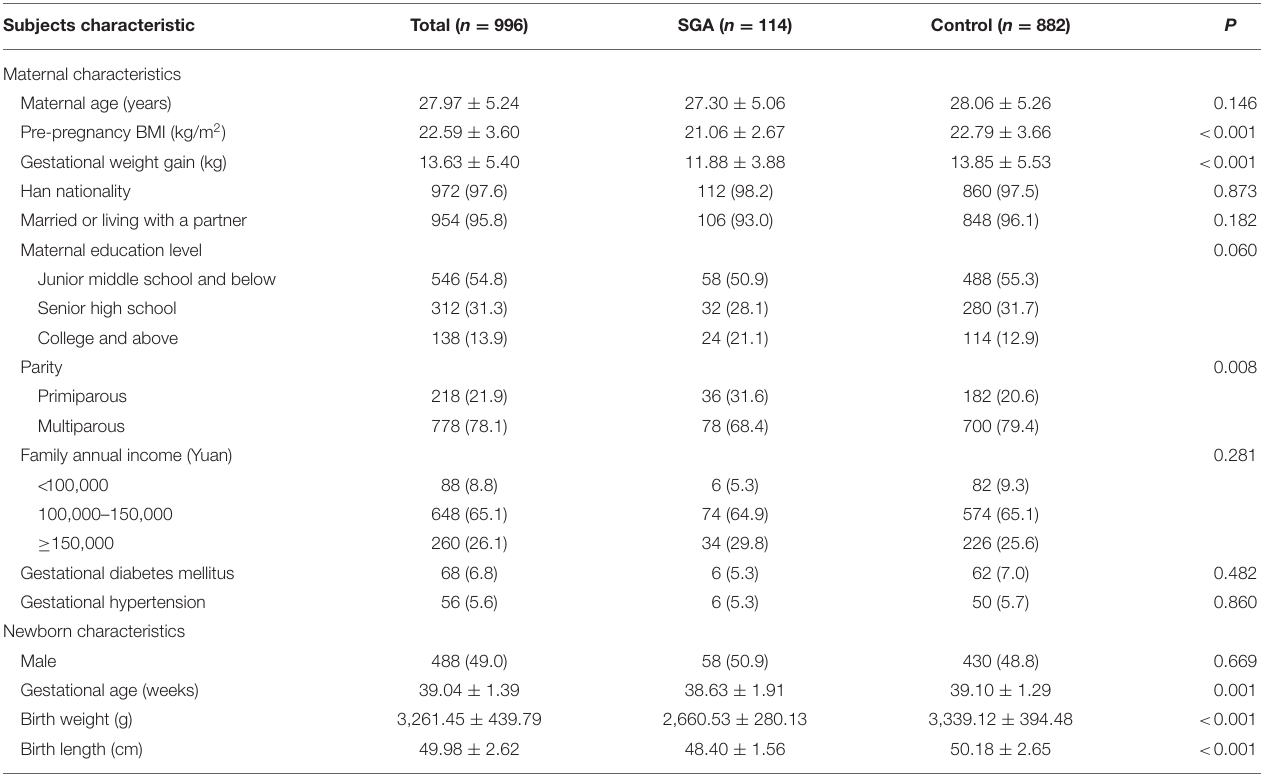
TABLE 1 | Participant characteristics.